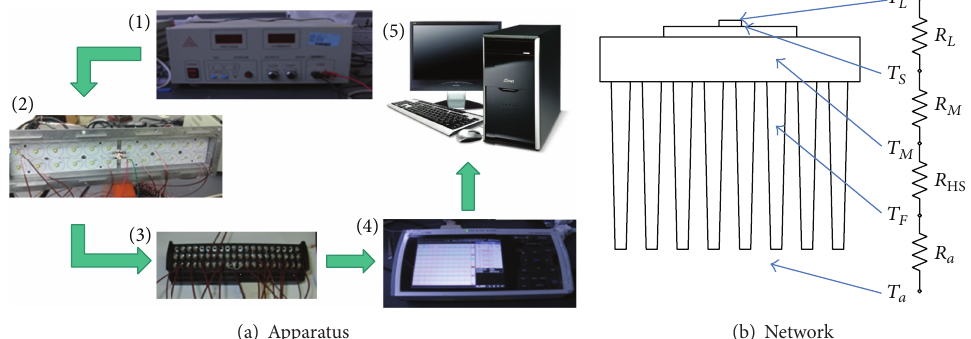
Figure 2: Experimental apparatus and thermal resistance network.